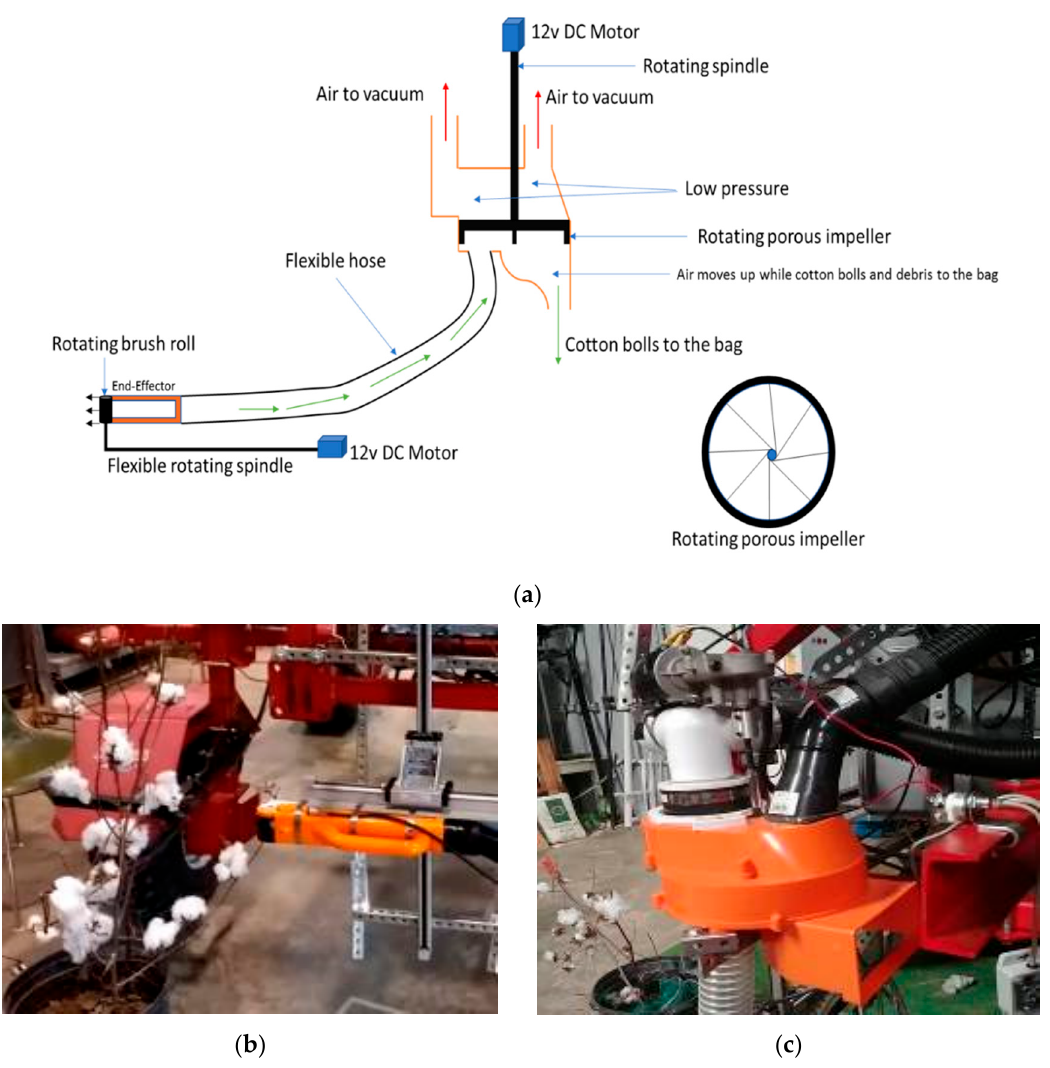
Figure 7. The end-effector was moved to the cotton bolls, using the Cartesian arm system, and then a rotating brush roller grabbed the bolls into the end-effector. An onboard vacuum transported the bolls to the rotating porous impeller, where the bolls were dropped into a collection bag.( a ) design of the cotton picking end-effector using vacuum( b ) End-effector is trying to pick the bolls by pointing directly to the boll ( c ) The vacuum chamber to separate cotton bolls from air to drop them to the